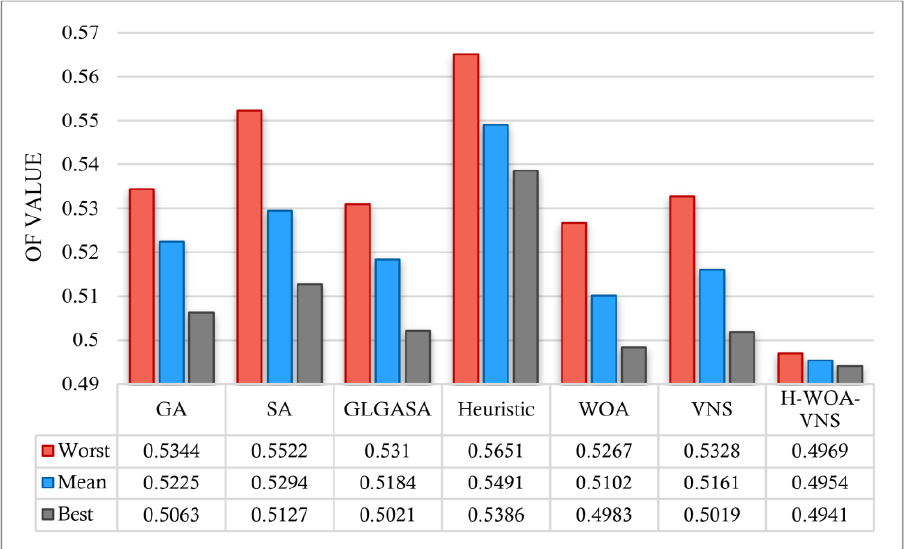
Figure 9. Sensitivity analysis of the environmental weights on the normalized economic cost: the lower the value for the weights of environmental objectives (either w CY or w PUE ) is, the higher the value for the economic objective ( w EC ) is considered, and thus, a lower economic cost ( Z EC ) is ob- tained.